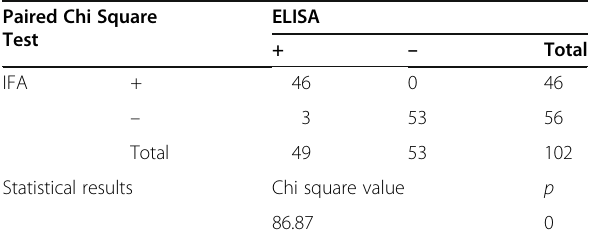
Table 2 Results of PCV3 serum samples detected by IFA and ELISA Paired Chi Square